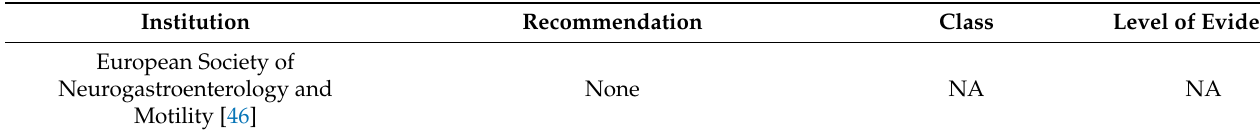
Table 2. Guidelines on the use of magnesium precautions for treating functional